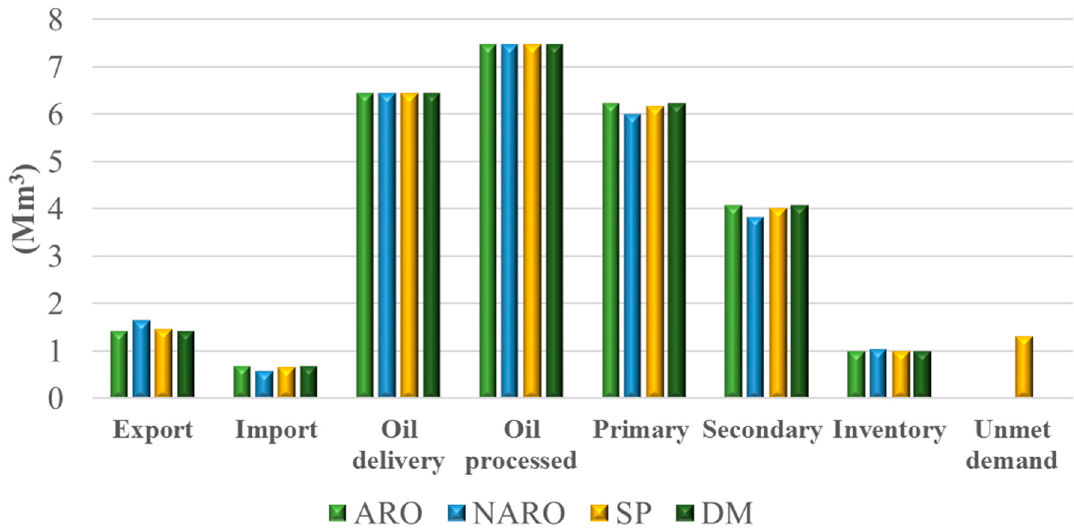
Figure 7. Network flows by solving the case study with different optimization models.